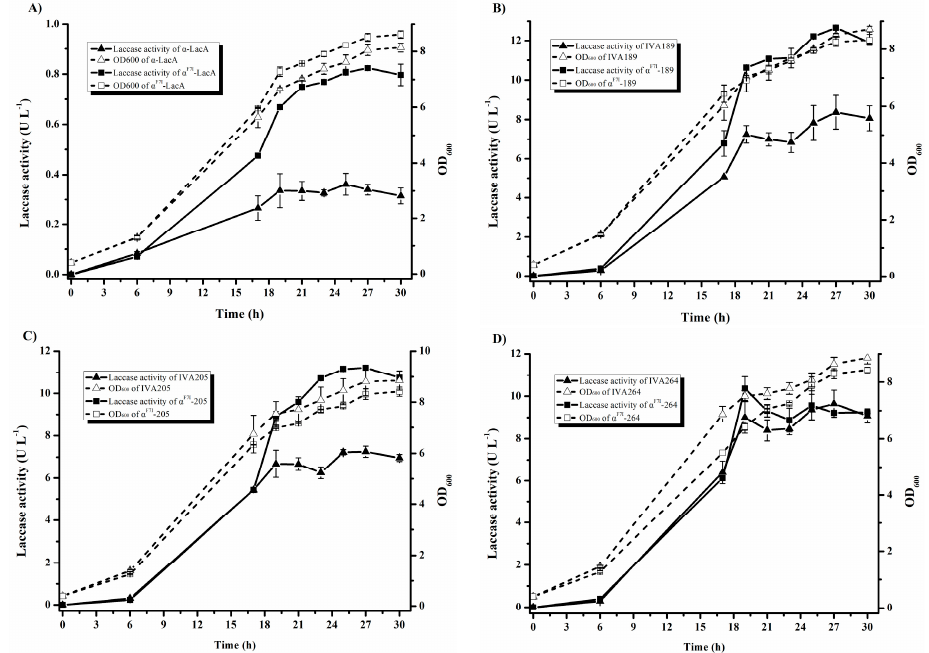
Figure 4. Cell growth and laccase production in S. cerevisiae BJ5465 expressing the parent-type laccase, LacA, and its mutants with the native α -factor and the evolved α -factor. ( A ) The parent-type laccase, LacA. ( B ) Mutant IVA189. ( C ) Mutant IVA205. ( D ) Mutant IVA264. The results represent the mean ± standard deviation of duplicate independent experiments ( p < 0.01).